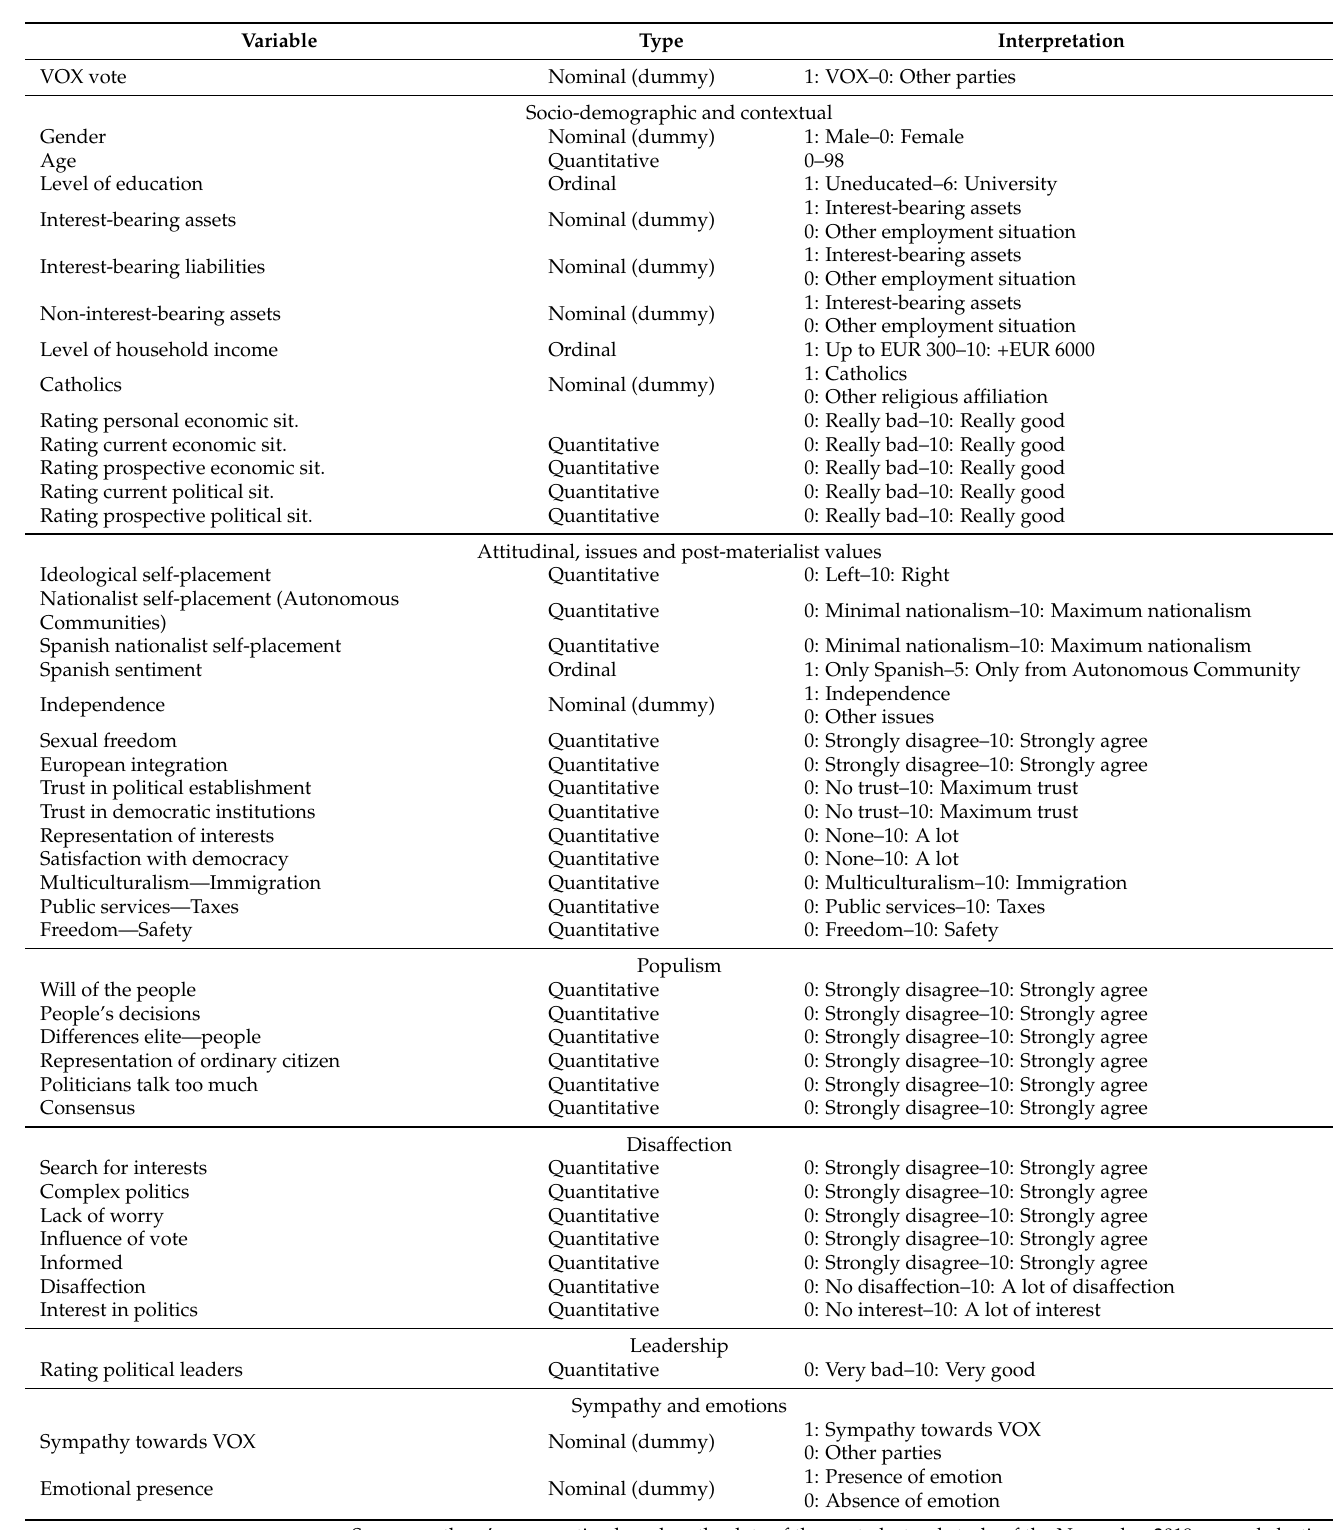
Table A1. Variables introduced in the explanatory models of the vote for